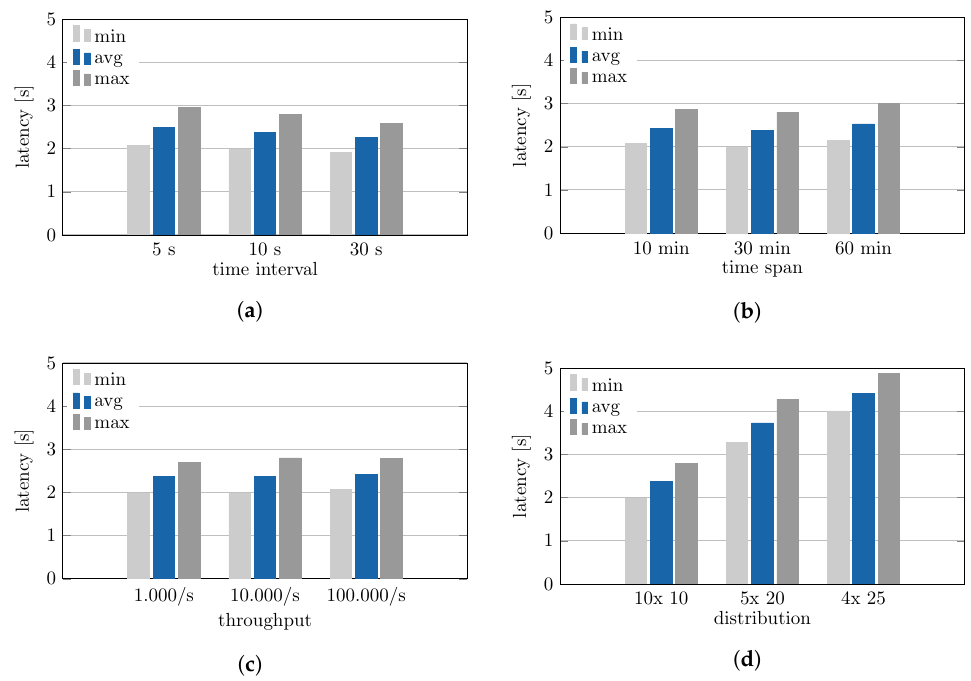
Figure 7. Processing latency measured during the performance tests: ( a ) for different time intervals, ( b ) for different time spans, ( c ) for different throughputs and ( d ) for different distributions of the parallel tests (Declaration: <no. of nodes> x <no. of parallel